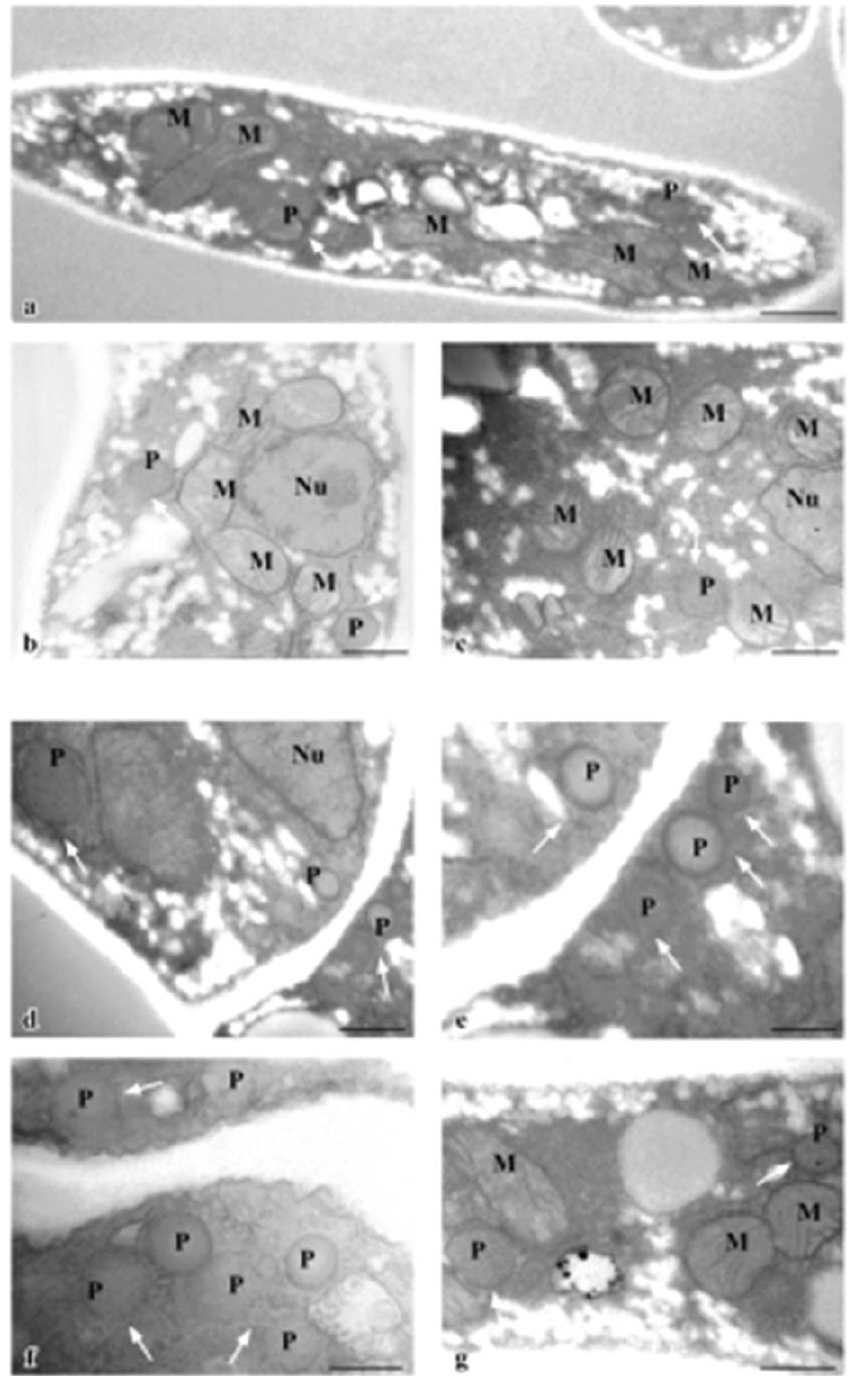
Figure 2. Ultrastructural characterization. TEM examination of A. flavus mycelia. Expression of P33 in AfP33 cells (D, E, F, G) significantly increases number of peroxisomes in comparison with WT cells (A, B, C). Bar 0.5 m m in A, B, C, D; bar 0.25 m m in E; bar 0.5 m m in F, G. (P, Peroxisomes; M, mitochondria; Nu, nucleus). doi:10.1371/journal.pone.0048097.g002 vs 0.5 m g/mL)(Figure9A)andupto10folds invivo (Figure9B)( , 100 vs 10 m g/g maize seed) compared to the WT strain. In the WT strain the aflatoxin biosynthesis started at 96 hpi, whereas in AfP33 it started one day before (1.55 ng/mL at 72 hpi – Figure 9A). AFB 1 production in vitro was higher up to 7 times ( , 3.5